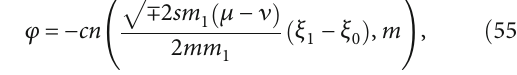
ffiffiffiffiffiffiffiffiffiffiffiffiffiffiffiffiffiffiffiffiffiffiffiffiffiffi ∓ 2 sm